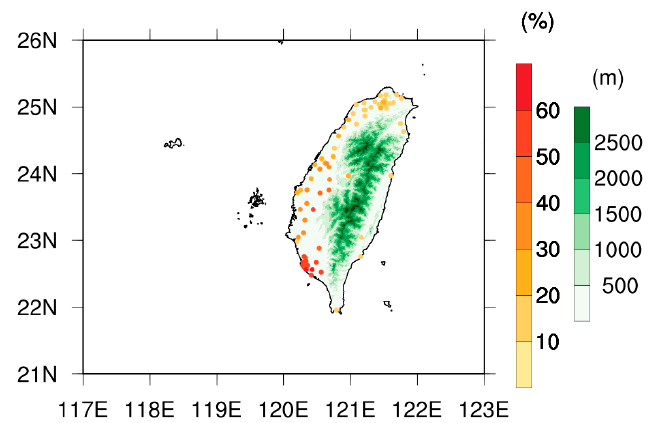
Figure 1. The terrain height distribution over Taiwan (green shadings) and locations of the Taiwan Environmental Protection Administration (EPA) air-quality stations (colored dots, with the red shading representing the climatological frequency of occurrence of severe air pollution events (fine particulate matter (PM 2.5 ) > 54.5 µ g m − 3 ) over 2006–2015 (unit: %) in each station.